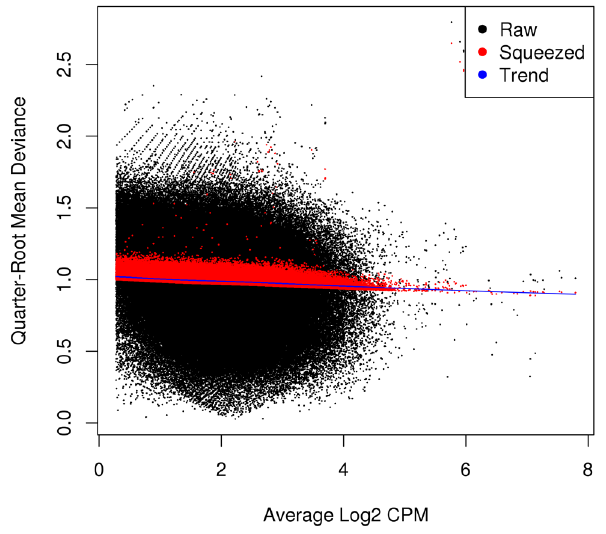
Figure 6. Effect of EB shrinkage on the raw QL dispersion estimate for each window (black) towards the abundance-dependent trend (blue) to obtain squeezed estimates